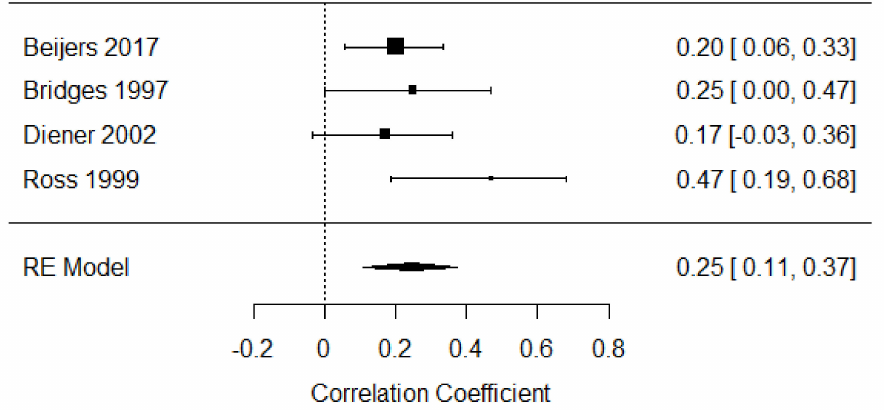
Figure 10. Forest plot of year 2 self-soothing strategies. Note: RE = Random-Effects Model. Third Year of